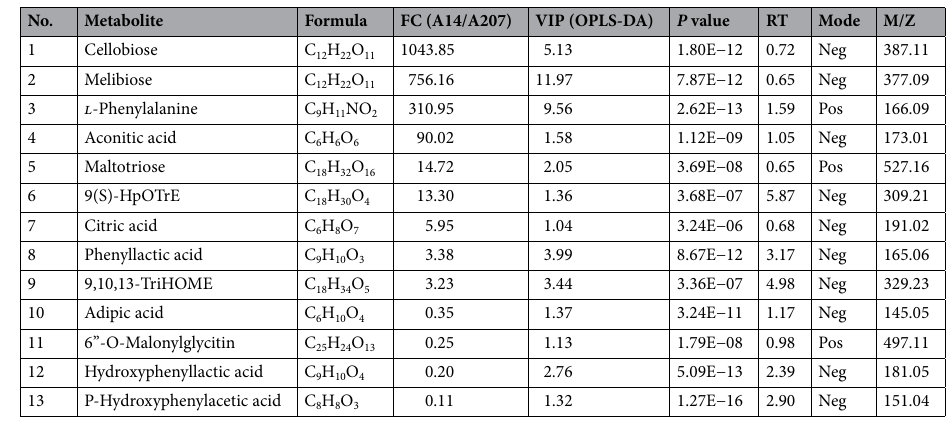
Table 3. Significant differential metabolites between the comparison groups of A14 group and A207 group. FC was the mean ratio between the A14 group and A207 group. Positive numbers represented that increasing in the A14 group compared with the A207 group, and negative numbers mean a decrease.